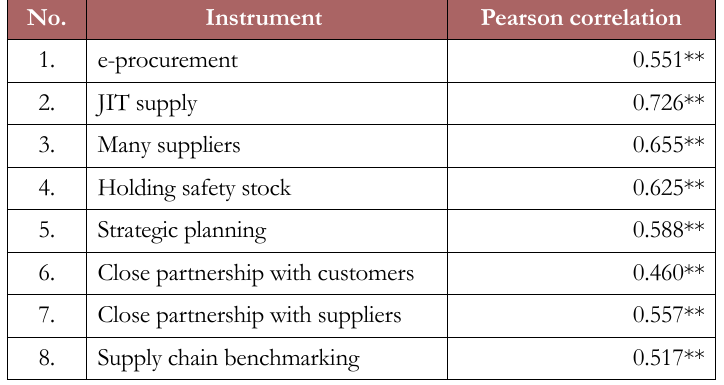
Table 3. Validity test of SCM variable